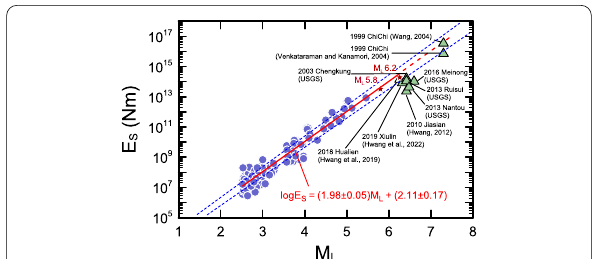
Fig. 3 Relation between logE S and M L , where E S is the radiated seismic energy and M L is the local magnitude. The logE S –M L relation has a slope of 1.98; therefore, logE S is almost proportional to 2.0M L . For comparison, also included in this plot are the E S of several earthquakes in Taiwan (IRIS DMC 2013; Venkataraman and Kanamori 2004; Wang 2004; Hwang 2012; Hwang et al. 2019, 2022; also see Table 1). The blue dashed lines denote the standard